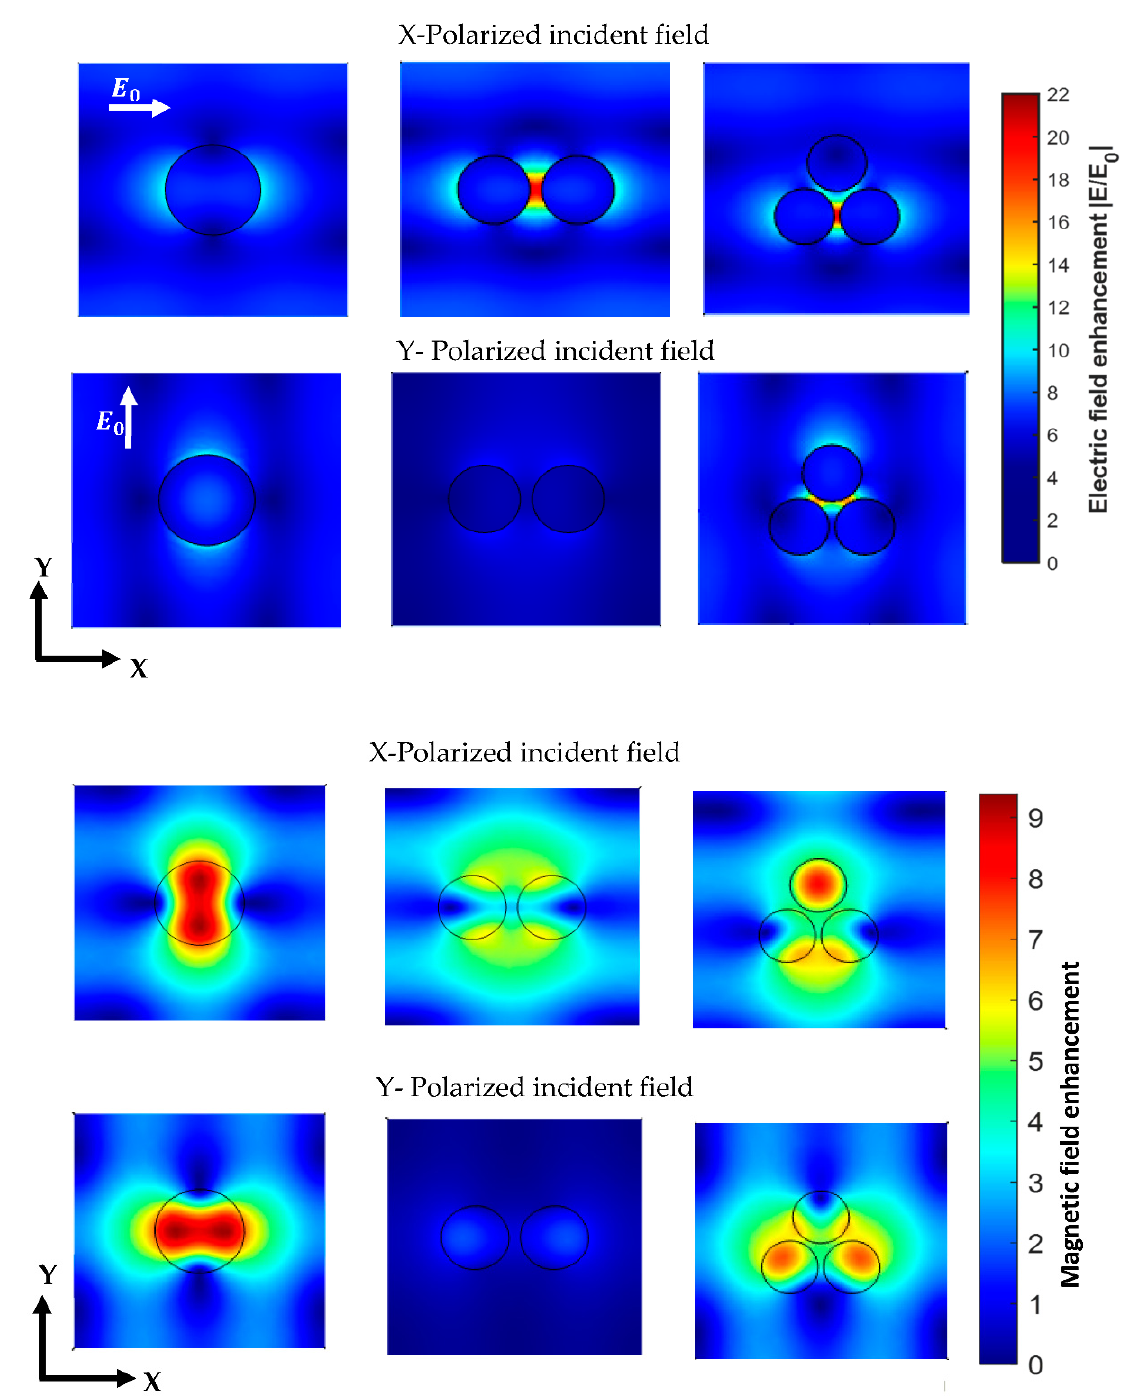
Figure 6. Simulated field maps of the electric and magnetic intensity distribution enhancement in the plane located at the center of the NSs. The incident field is excited at λ = 650 nm.